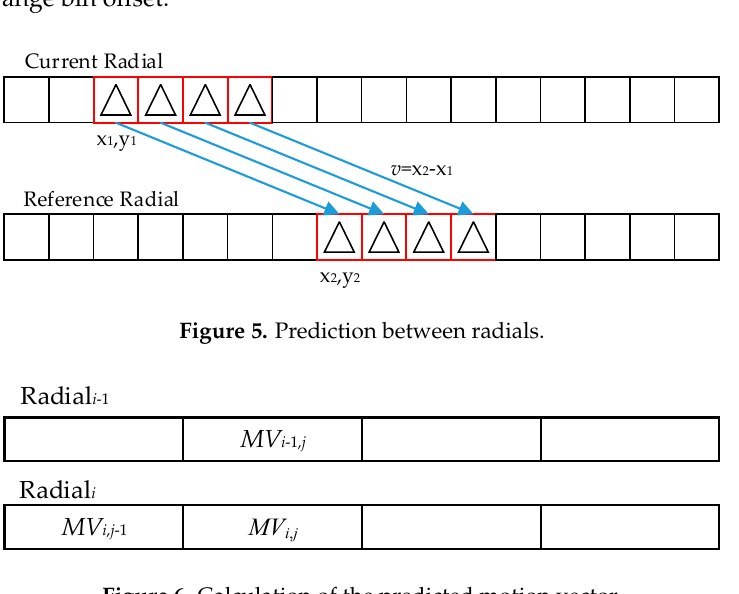
Figure 6. Calculation of the predicted motion vector.